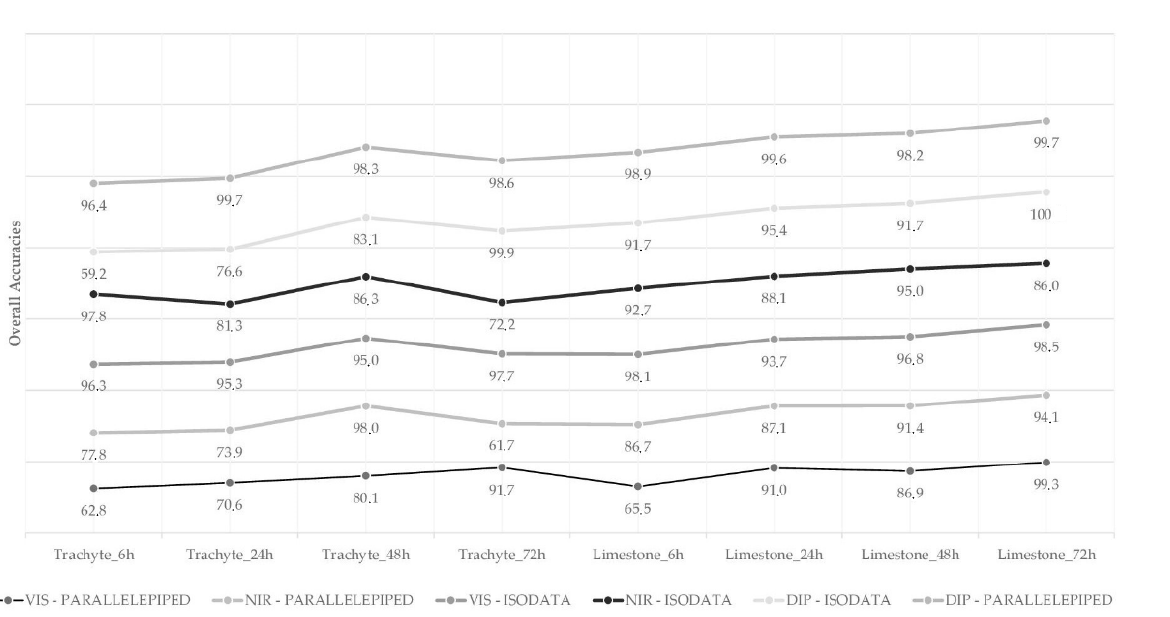
Figure 11. Averaged overall accuracy for each mixture and technique during the rolling-bottle test.